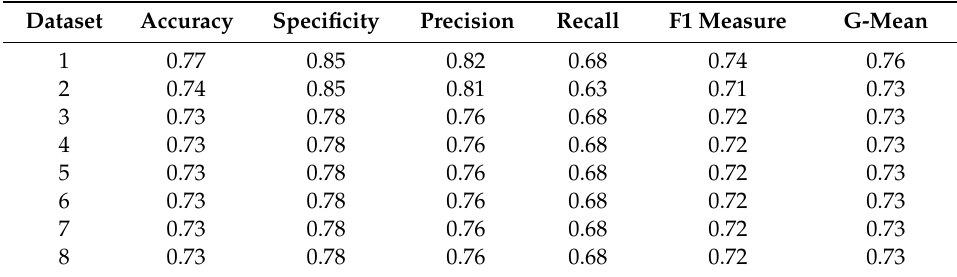
Table 6. Results of Naïve Bayes.